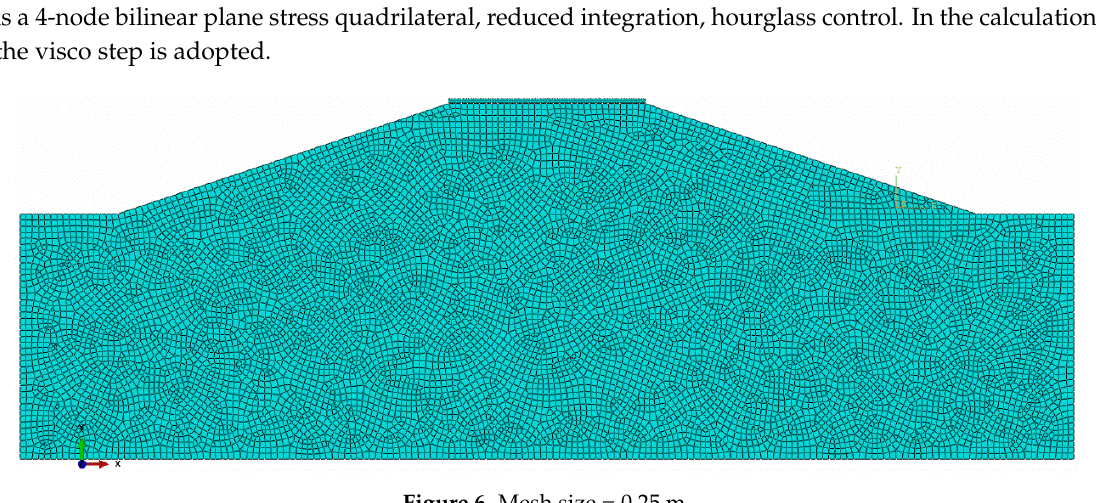
Table 2. Material parameters for calculation.